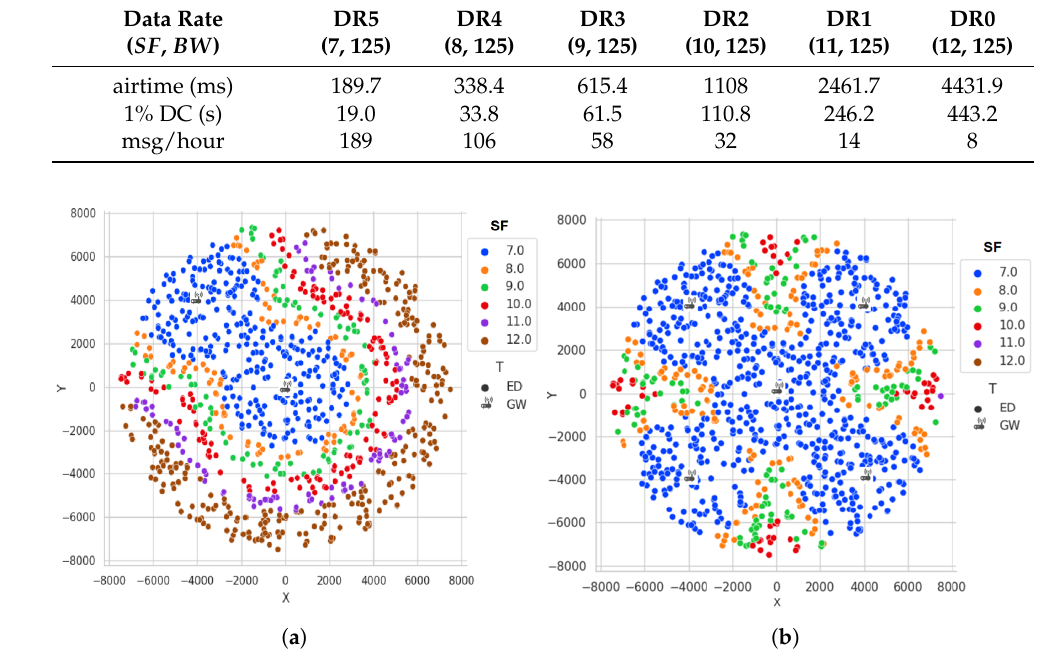
Figure 4. ( a ) SF allocation with 2 GWs ; ( b ) SF allocation with 5 GWs . SF allocation according to the number of gateways deployed in the case of 1000 EDs.